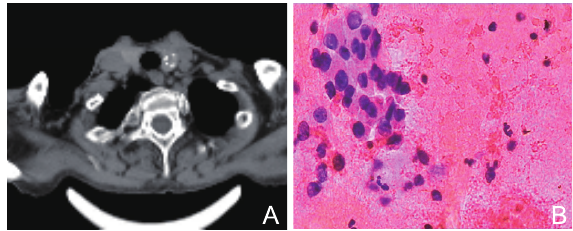
Figure 3 (A) After 17 hours, the CT manifestation of the thyroid showed the thyroid size returned to the original. (B) Pathology of FNAB showed multiple atypical thyroid follicular epithelium cells (marked by the white